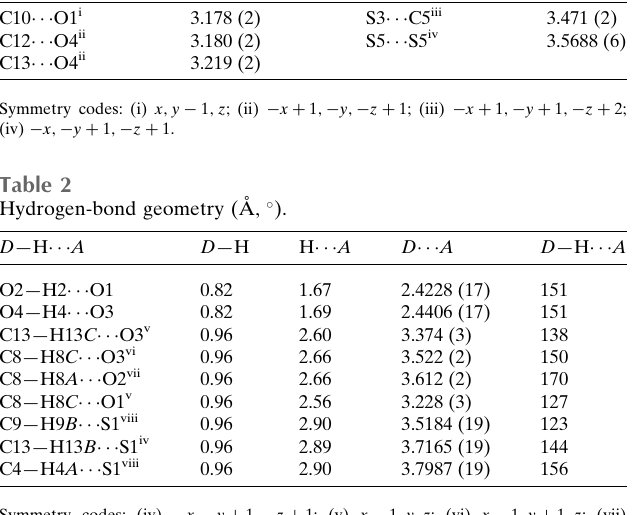
Fig. 4 b ), H (cid:4) (cid:4) (cid:4) H (25.8%; Fig. 4 c ), O (cid:4) (cid:4) (cid:4) H/H (cid:4) (cid:4) (cid:4) O (19.5%; Fig. 4 d ), C (cid:4) (cid:4) (cid:4) H/H (cid:4) (cid:4) (cid:4) C (9.3%; Fig. 4 e ), S (cid:4) (cid:4) (cid:4) C/C (cid:4) (cid:4) (cid:4) S (4.9%; Fig. 4 f ), S (cid:4) (cid:4) (cid:4) O/O (cid:4) (cid:4) (cid:4) S (4.8%; Fig. 4 g ), S (cid:4) (cid:4) (cid:4) S (4.0%; Fig. 4 h ), O (cid:4) (cid:4) (cid:4) C/C (cid:4) (cid:4) (cid:4) O (2.0%; Fig. 4 i ), O (cid:4) (cid:4) (cid:4) O (1.1%; Fig. 4 j ), and C (cid:4) (cid:4) (cid:4) C